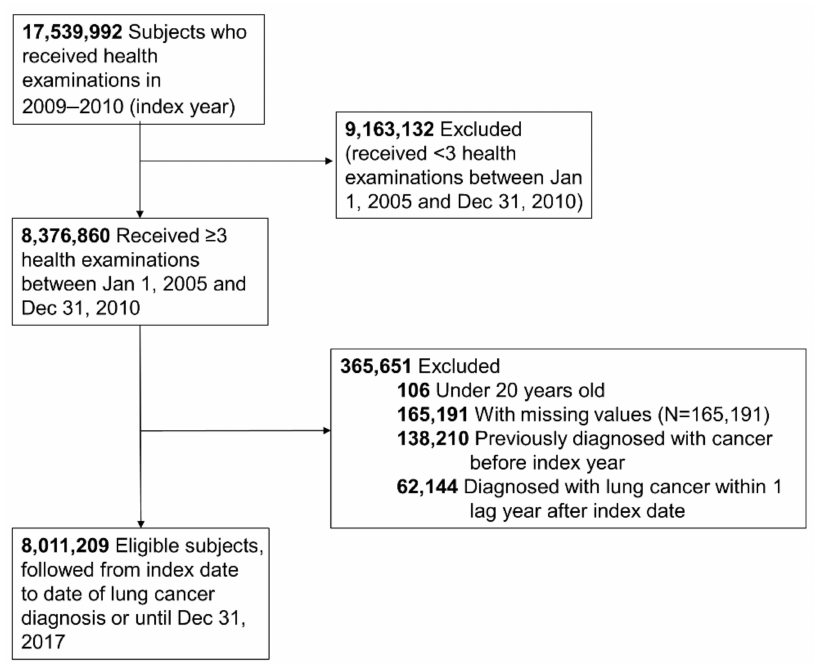
Figure 1. Flowchart of the study